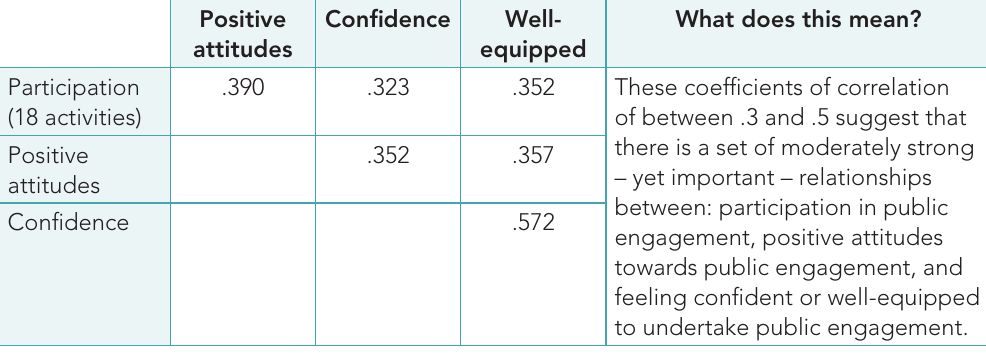
feeling confident or well-equipped to undertake public